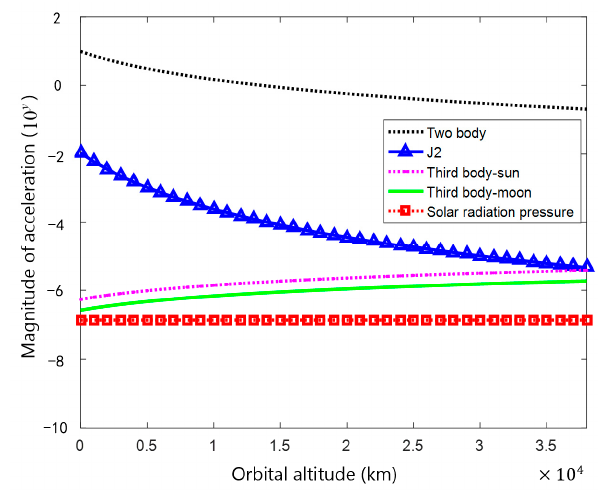
Figure 1. Magnitude of acceleration vs. orbital altitude. As shown in Figure 1, the Earth’s central gravity acceleration and J2 perturbation are the main perturbations, and the luni-solar perturbations increase gradually as the orbital altitude increase. The Earth’s nonspherical perturbations and luni-solar perturbations are conservative forces that do not decrease the orbital altitude of MEO satellites; however, they influence the orbital inclination and eccentricity. The solar radiation pressure perturbation can affect the orbit of MEO satellites periodically; their impacts could not be ignored as in an MEO satellite with a large area-to-mass